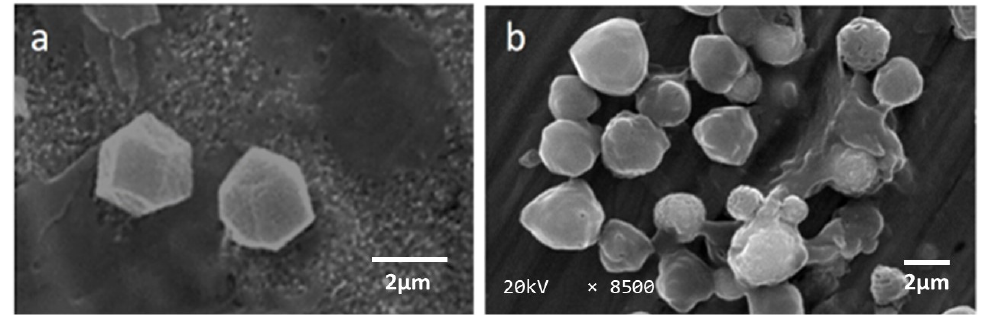
Figure 1. Morphological structure of ( a ) Helicoverpa armigera nuclear polyhedrosis virus ( Ha NPV) and ( b ) Helicoverpa armigera nuclear polyhedrosis virus subcultured ( Ha NPV 1 ) occlusion bodies/OBs or polyhedra isolated from Spodoptera litura (Fabr.) larvae.